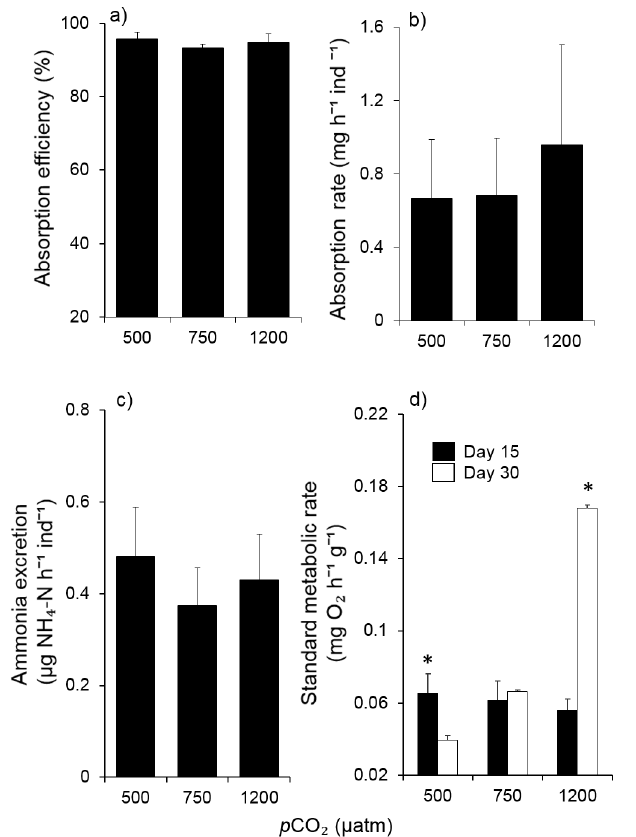
Fig. 2. (a) Absorption efficiency, (b) absorption rates, (c) ammonia excretion, and (d) metabolic rates of the mussel Choromytilus chorus exposed to contrasting p CO 2 levels. Bars correspond to means ±1 SE. Asterisk indicates signifi- cant differences among treatments (Tukey’s HSD